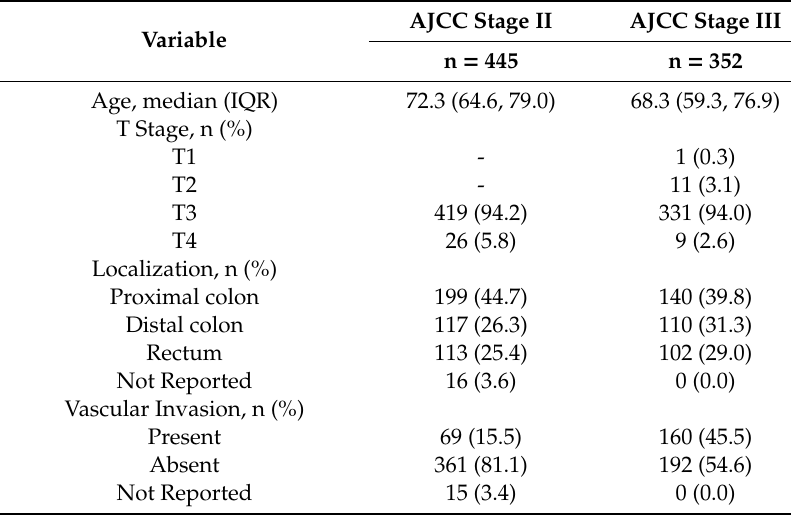
Table 1. Cohort characteristics by